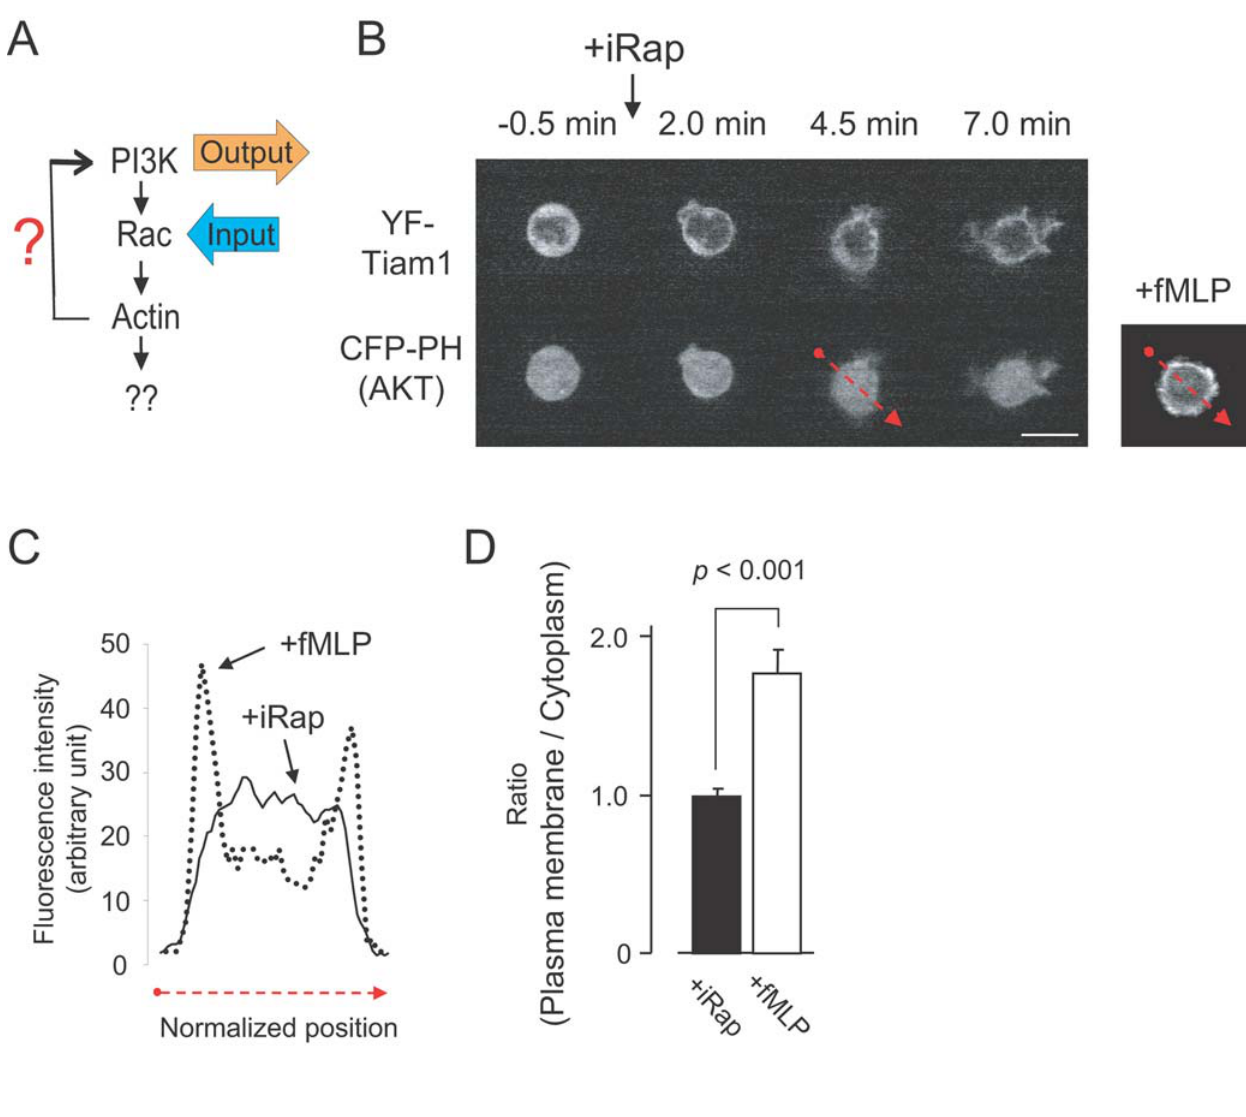
Figure 6. Endogenous Rac activation does not enhance PIP 3 levels in cells. (A) Schematic representation of experiments conducted in (B) to (D). (B) Time series analysis showing that synthetic activation of endogenous Rac triggers pseudopod extensions but no measurable increase in PIP 3 concentration. Top row shows the YFP-conjugated Rac activator construct (YF-Tiam1), and the bottom row the PIP 3 biosensor CFP-PH(AKT). The panel on the right is shown as a control, demonstrating that cells induce a strong CFP-PH(AKT) translocation in response to fMLP. (C) Distribution of the YFP-PH(AKT) fluorescence intensity in (B) for a cross section through a cell where Rac has been synthetically activated (red dotted arrow in top panel). A comparison to a control cell is shown stimulated with fMLP instead of iRap. (D) Statistical analysis showing the ratio of the fluorescent intensity at the plasma membrane over the cytoplasm (lower right panel). Error bars represent S.E.M. (n . 15 from more than three independent experiments). Scale bars, 10 m